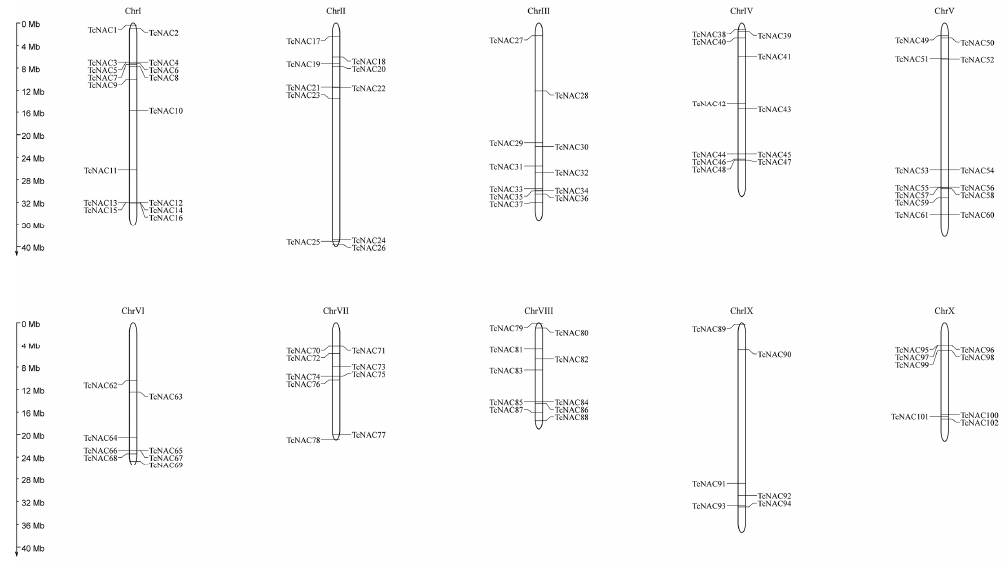
Figure 3. Distribution of TcNAC genes among 10 chromosomes. Vertical bars represent the chromosomes of Theobroma cacao . The chromosome number is to the top of each chromosome. The scale on the left represents chromosome length.